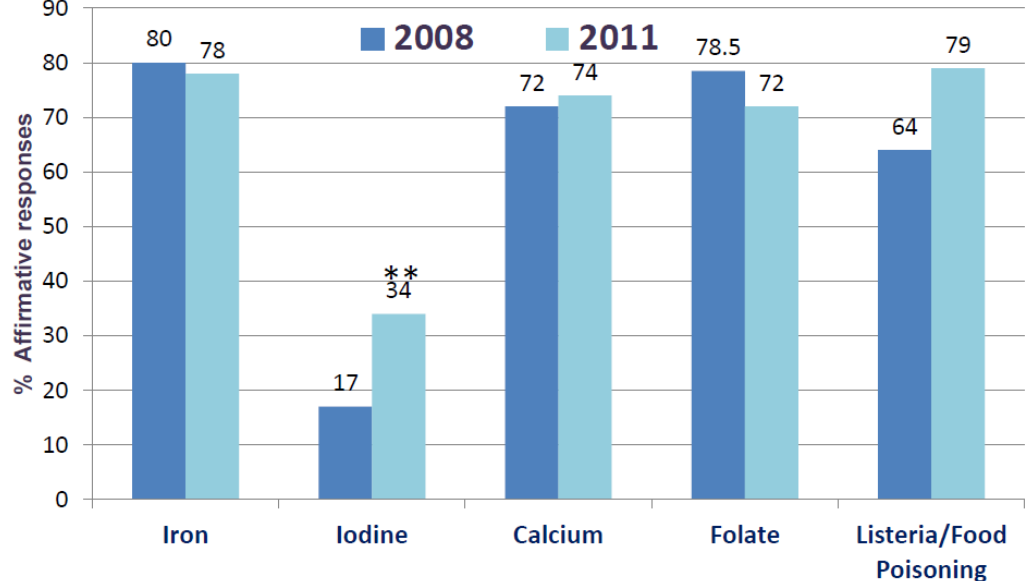
Figure 2. Pregnant womens’ responses regarding whether they had received sufficient dietary information on nutrition while pregnant to make informed decisions: Pre- (2008) and Post-fortification (2011).